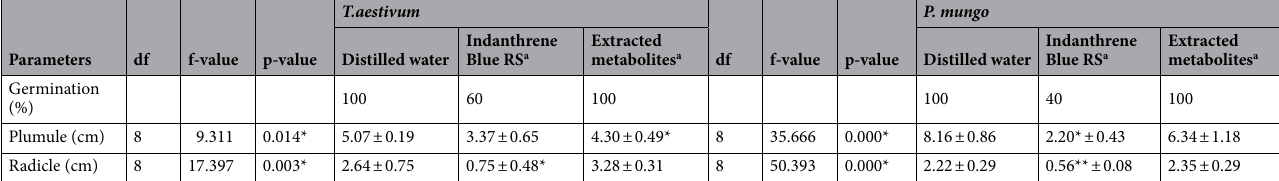
Table 5. Phytotoxicity studies of Indanthrene Blue RS, textile effluent, and its metabolites formed after degradation by consortium-BP. df: degrees of freedom. Values are mean of three experiments, SEM ( ±), significantly different from the seeds germinated in distilled water (control) at *P < 0.05, **P < 0.01, by one-way ANOVA with Tukey’s-HSD Comparisons Test. a Concentration = 500 mg L −1